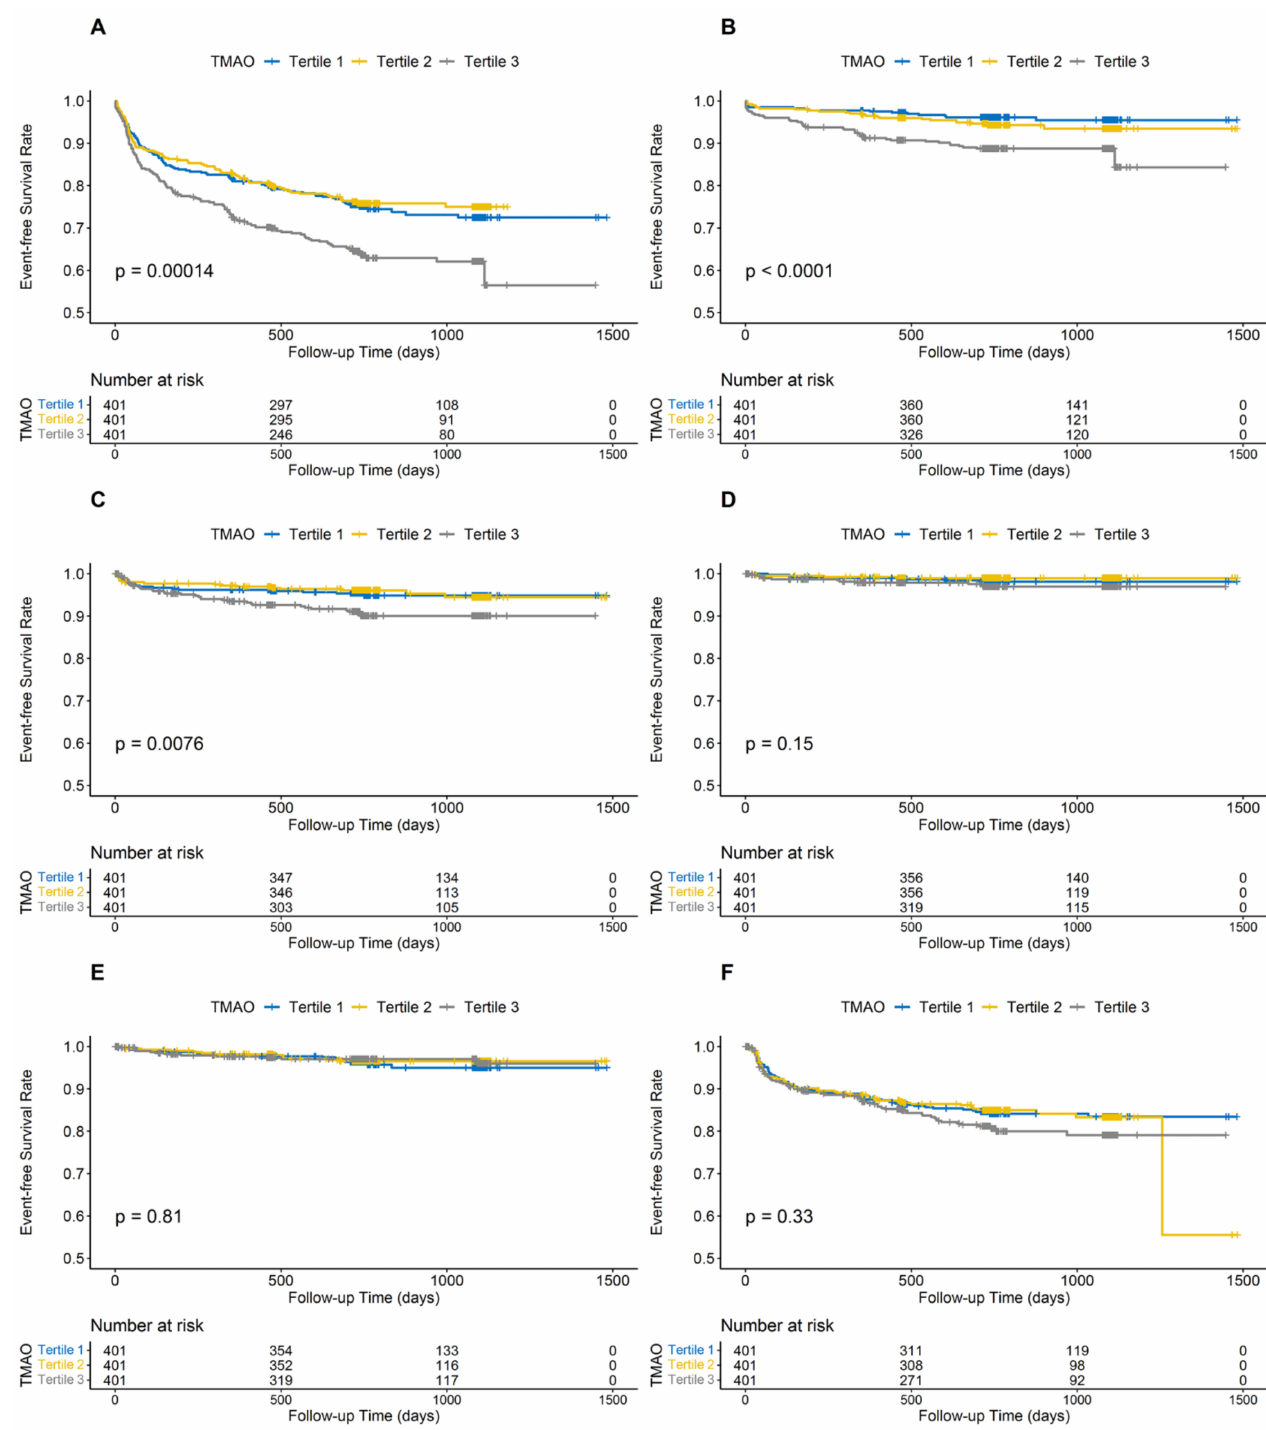
Figure 1. Kaplan—curve for cumulative event-free survival in groups stratified by TMAO tertile levels at enrollment. ( A ) major adverse cardiovascular event, ( B ) all-cause death, ( C ) myocardial infarction, ( D ) rehospitalization caused by heart failure; ( E ) stroke; ( F ) revascularization. TMAO,